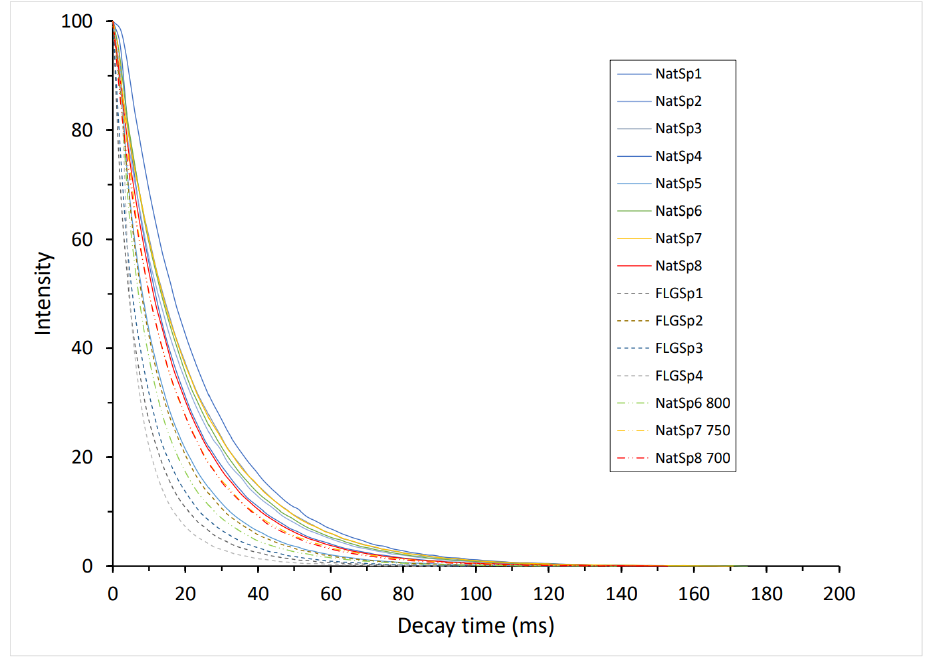
Figure 8. The photoluminescence decay curves at 685 nm of spinel: natural spinel versus the heated and flux lab-grown spinel samples.